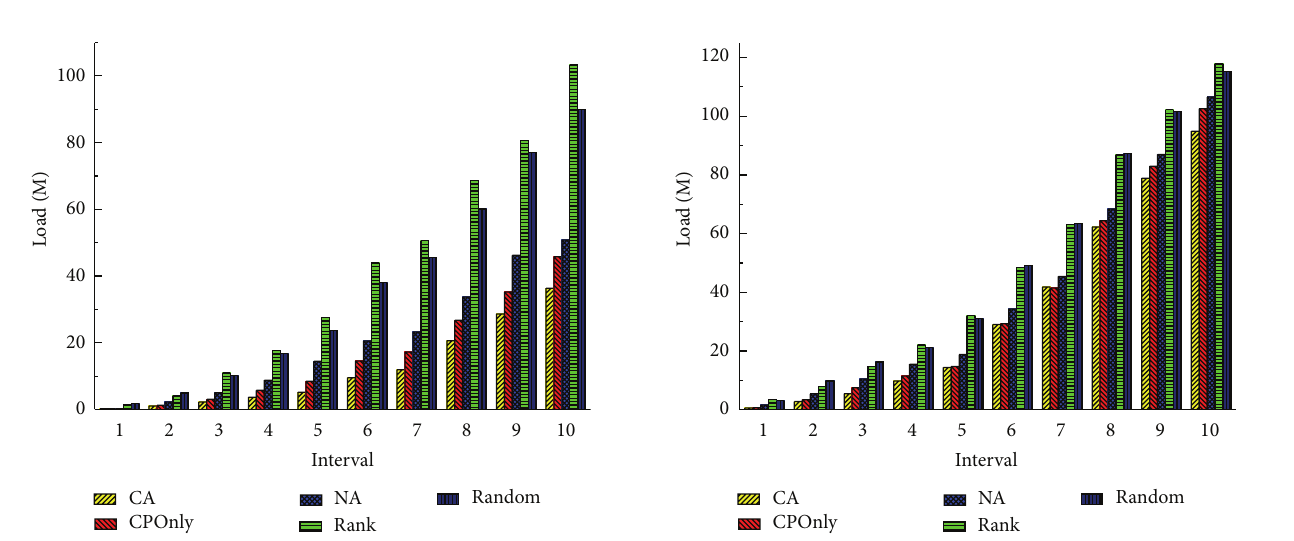
Figure 10: Total latency of all services (10 nodes).